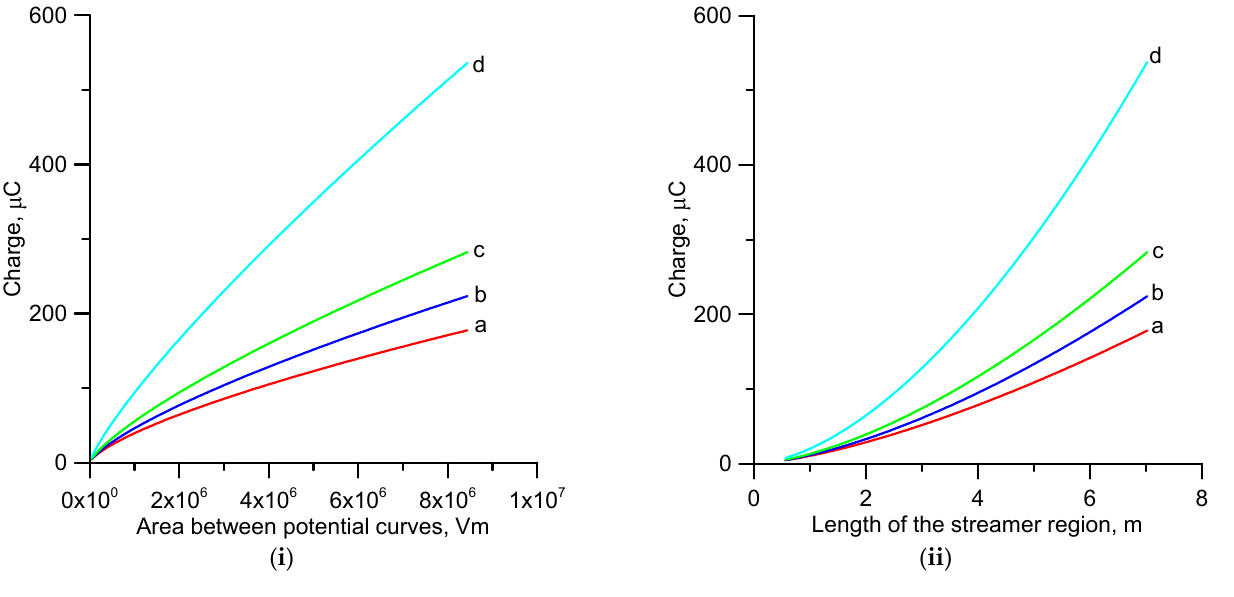
Figure 7. ( i ) The best fit curves for the charge in the streamer region versus the area between the two potential curves, as illustrated in Figure 1. ( ii ) The best fit curves for the charge in the streamer region versus the length of the streamer region. (a) Without branches; (b) branching length 10 mm; (c) branching length 5 mm; (d) branching length 2 mm.